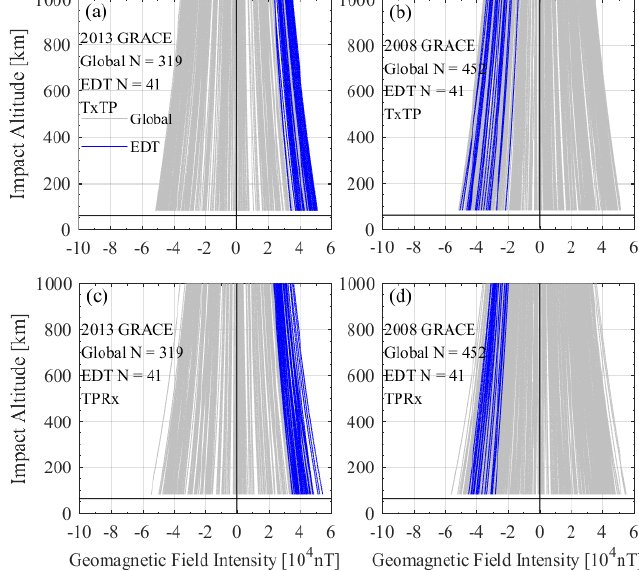
Figure 12. Profiles and their statistics of the BNe remainder term (rightmost term of Equation (11)) for the global ensemble data sets of MetOp-A/-B missions on 15 May and 15 July 2013 ( left panel ), GRACE mission on 15 May and 15 July 2013 ( middle panel ), and CHAMP mission on 14–16 July 2008 ( right panel ), respectively. In each subpanel, the individual bending angle RIEs (gray), their mean (heavy red), and their standard deviation (heavy green) are shown.